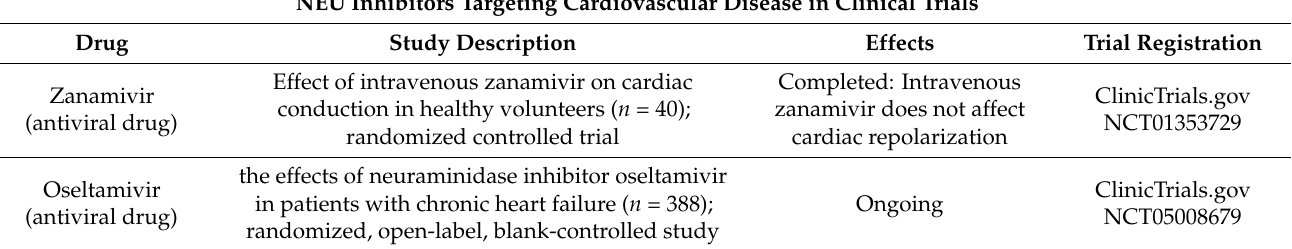
Table 3. Overview of clinical trials targeting NEUs in cardiovascular diseases. NEU Inhibitors Targeting Cardiovascular Disease in Clinical